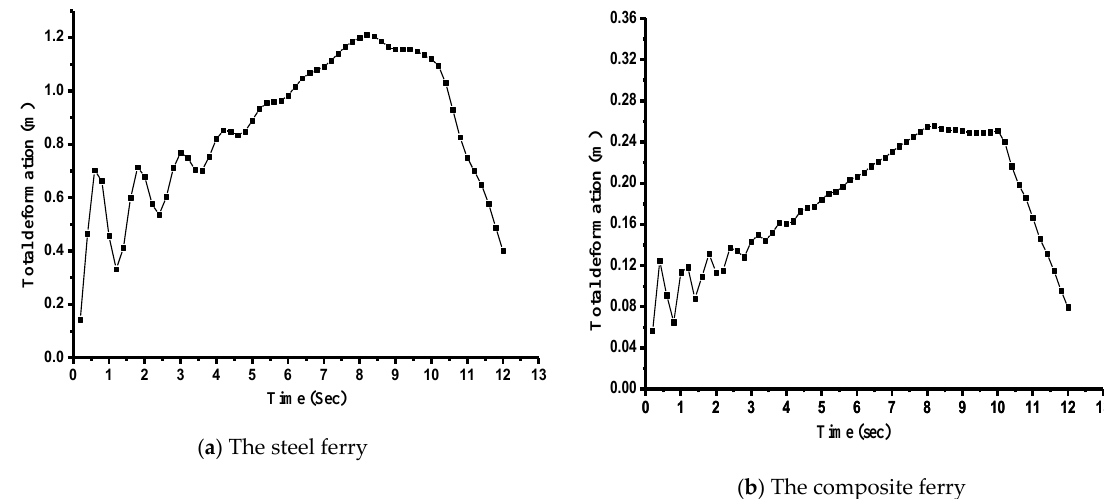
Figure 24. The total deformations with time for case 2.